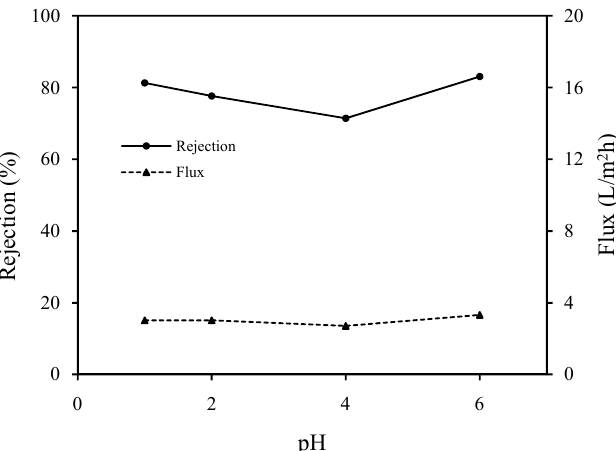
Fig. 11. Permeate flux and rejection percent of cobalt ions by the MMM containing 22 wt. % PES, 0.6 wt.% fMWCNTs versus the pH of the feed solution (20 bar, 40 L/h, 20 ppm Co(NO 3 ) 2 , 90 min)